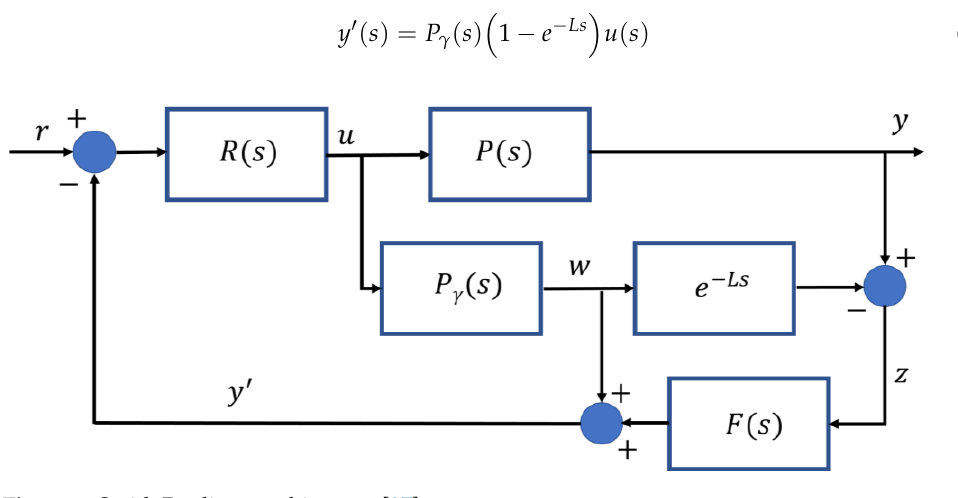
Figure 1. Smith Predictor architecture